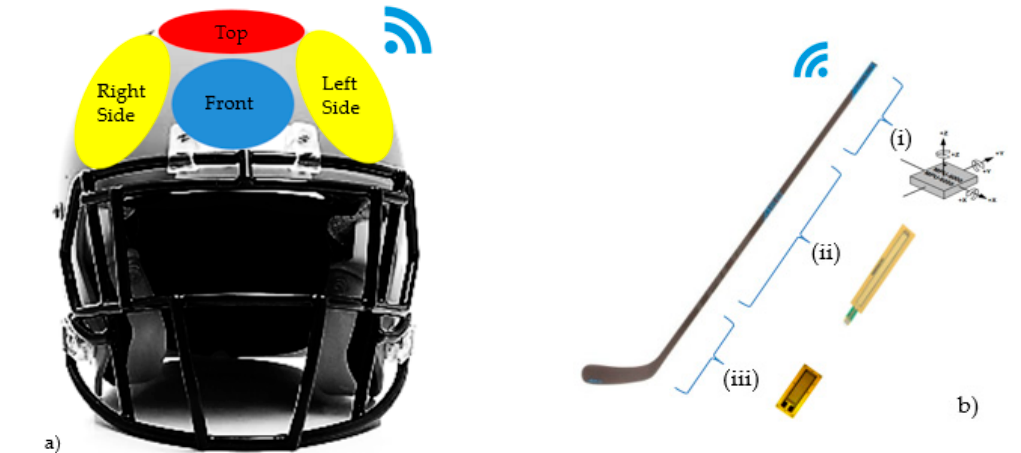
Figure 6. Instrumented smart helmet ( a ) and instrumented smart stick ( b ).